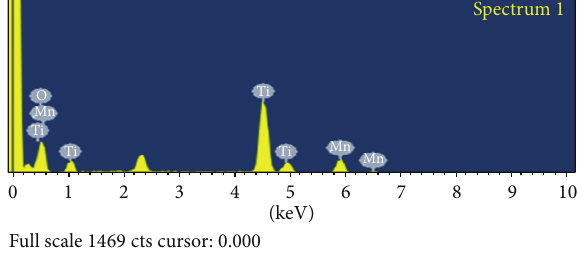
Figure 4: EDX spectra of 1% iron doped TiO 2 .